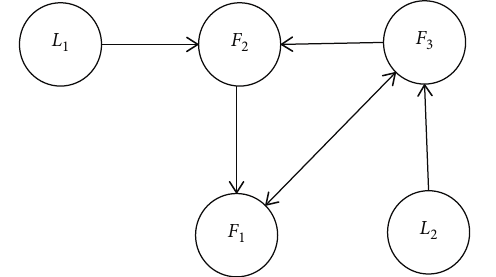
Figure 1: Directed communication graph.